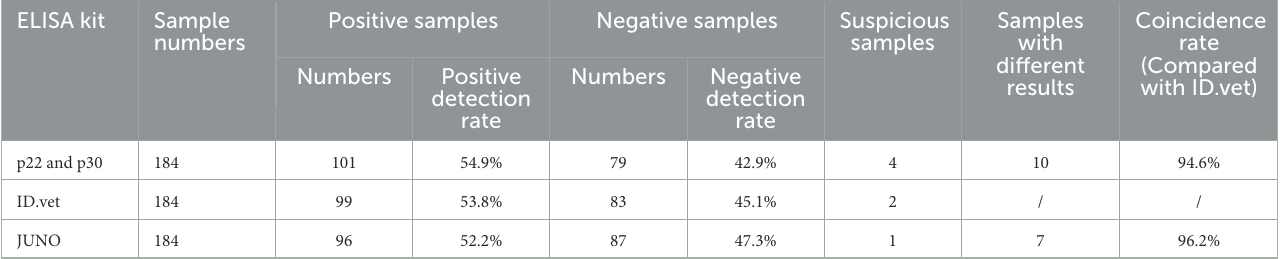
TABLE 5 Coincidence rate of clinical